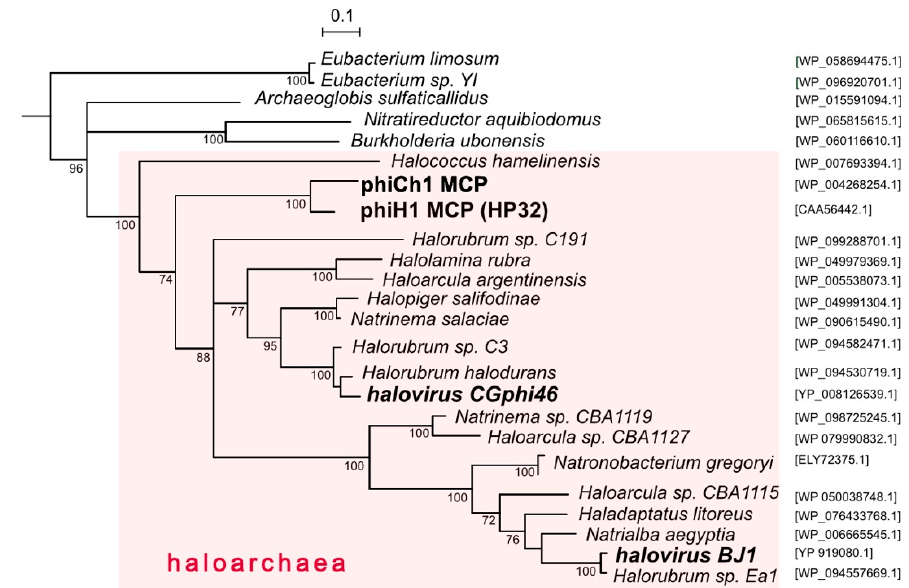
Figure 4. Phylogenetic tree reconstruction (NJ method) of major capsid proteins (MCP) of phiH1, other haloviruses and related proteins of haloarchaea. Species names of haloarchaeal species are shown, with accession numbers given at the right side. Bootstrap confidence values (100 repetitions) are shown at branch points. The pink shading highlights taxa belonging to the class Halobacteria. Scale bar (expected changes per site) is shown at top. The outgroup (not shown) consisted of distantly related MCP sequences of Bacillus spp. (WP_001060157.1, WP_098773561.1, WP_001064748.1 and WP_000178926.1). Figure S1: Original phiH1 restriction map compared to in silico map from genome sequence. Figure S2: Dot plot sequence comparison of phiH1 and phiCh1